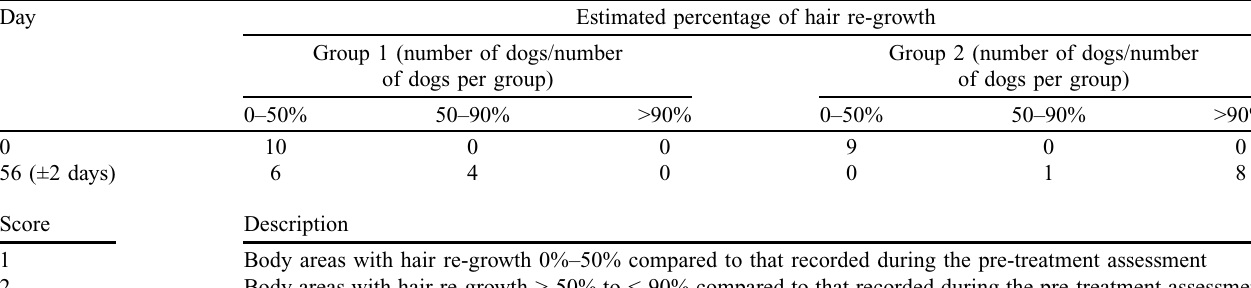
Table 4. Estimated percentage of hair re-growth from baseline and between groups.